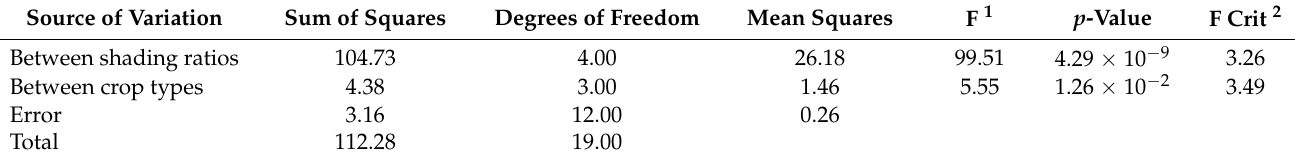
Table 4. Comparison of crop growth with the four shading ratios of (0, 21.3, 25.6, and 32)%. Source of Variation Sum of Squares Degrees of Freedom Mean Squares F 1 p -Value F Crit 2 Between shading ratios